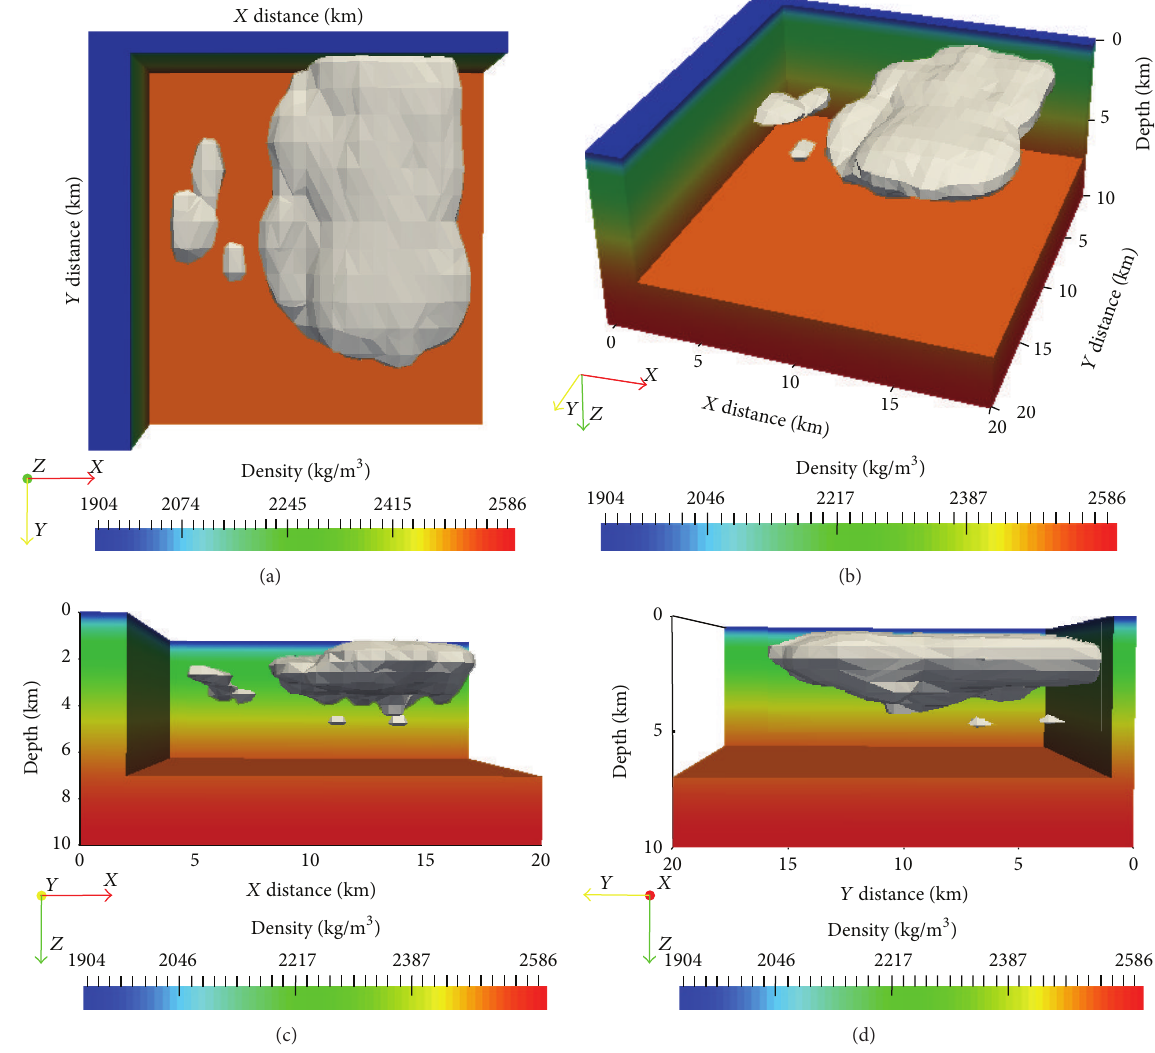
Figure 11: 3D Inverted Model generated from the 3D gravity anomaly